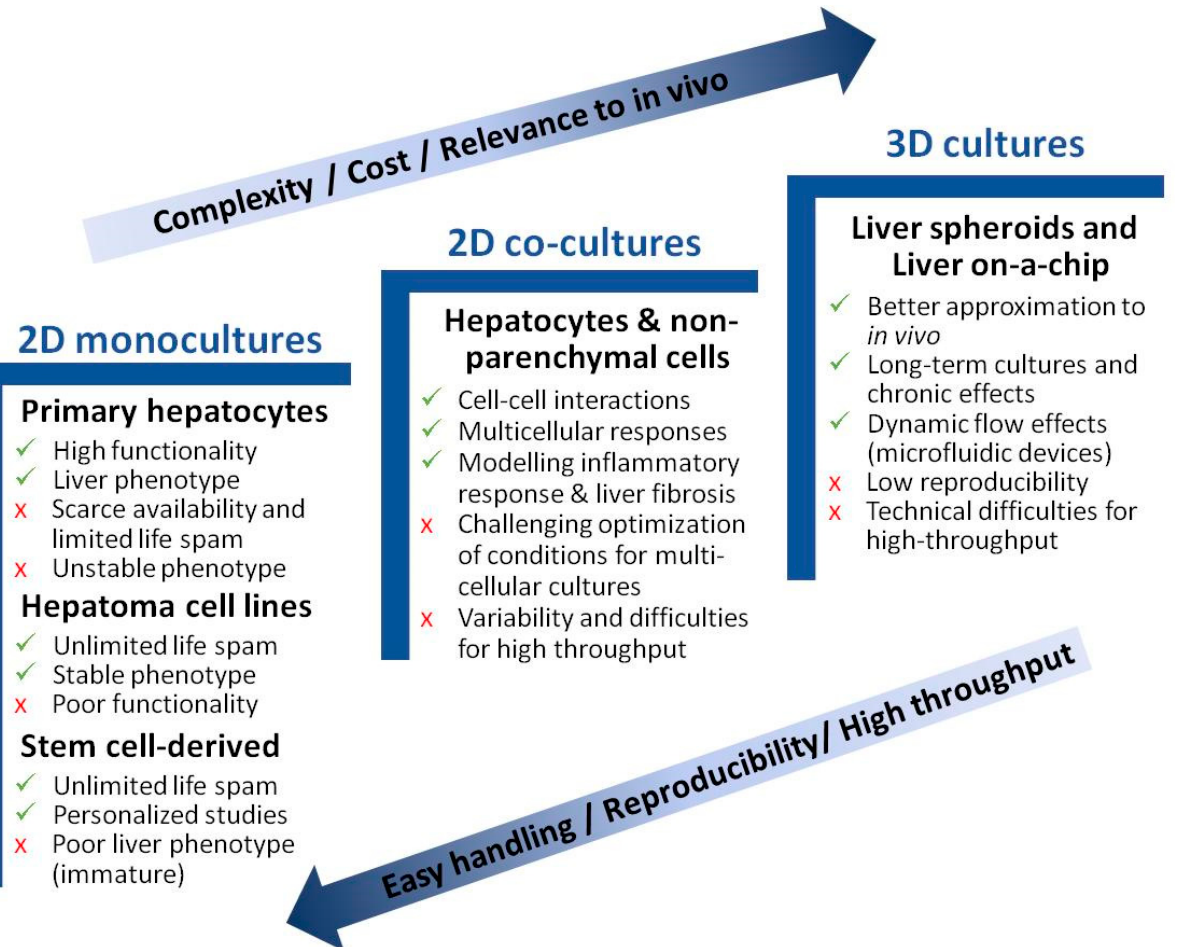
Figure 2. Advantages and disadvantages of in vitro models for studying NAFLD. Cell culture models are listed per increasing cost, longevity, and complexity. Simpler models are better suited for high-throughput applications.